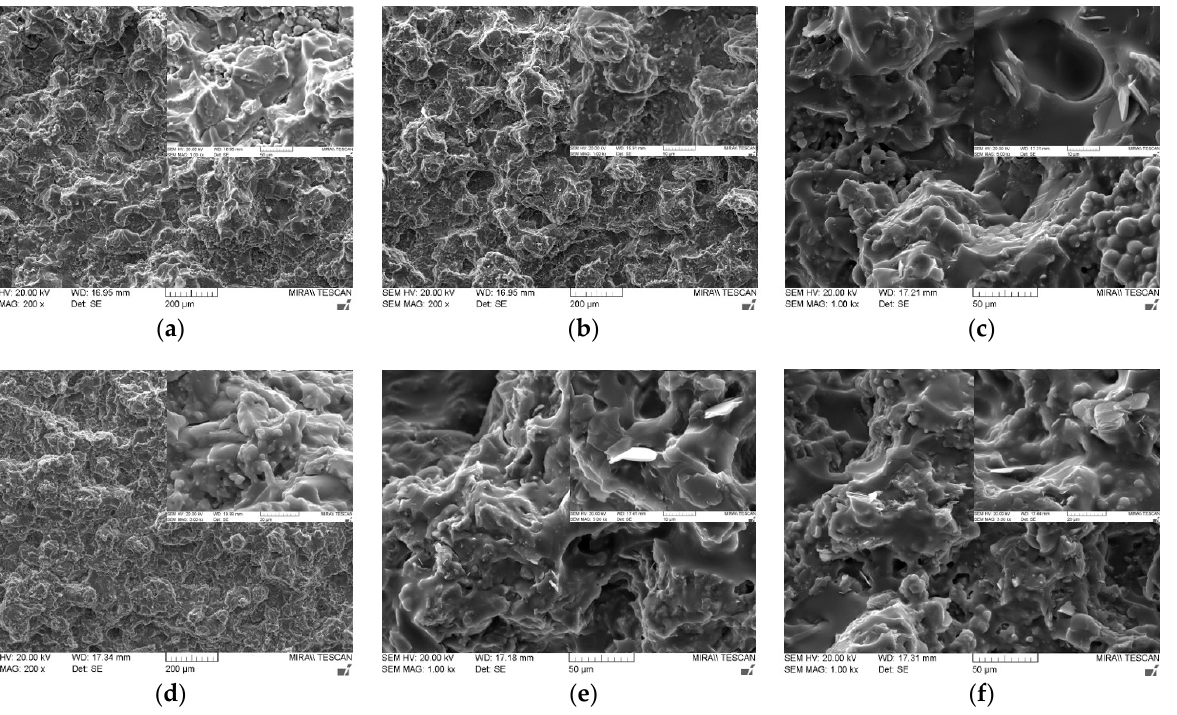
Figure 5. Thethe rmal conductivity and adhesion strength of fluorosilicone adhesives containing three ‐ component MgO and BN fillers: ( a ) thermal conductivity of trimodal MgO; ( b ) thermal conductivity of trimodal MgO2/BN1; ( c ) thermal conductivity of trimodal MgO1/BN2; ( d ) adhesion strength of trimodal MgO at 23 °C, 180 °C, 250 °C; ( e ) adhesion strength of trimodal MgO2/BN1 at 23 °C, 180 °C, 250 °C; ( f ) adhesion strength of trimodal MgO1/BN2 at 23 °C, 180 °C, nad250 °C.